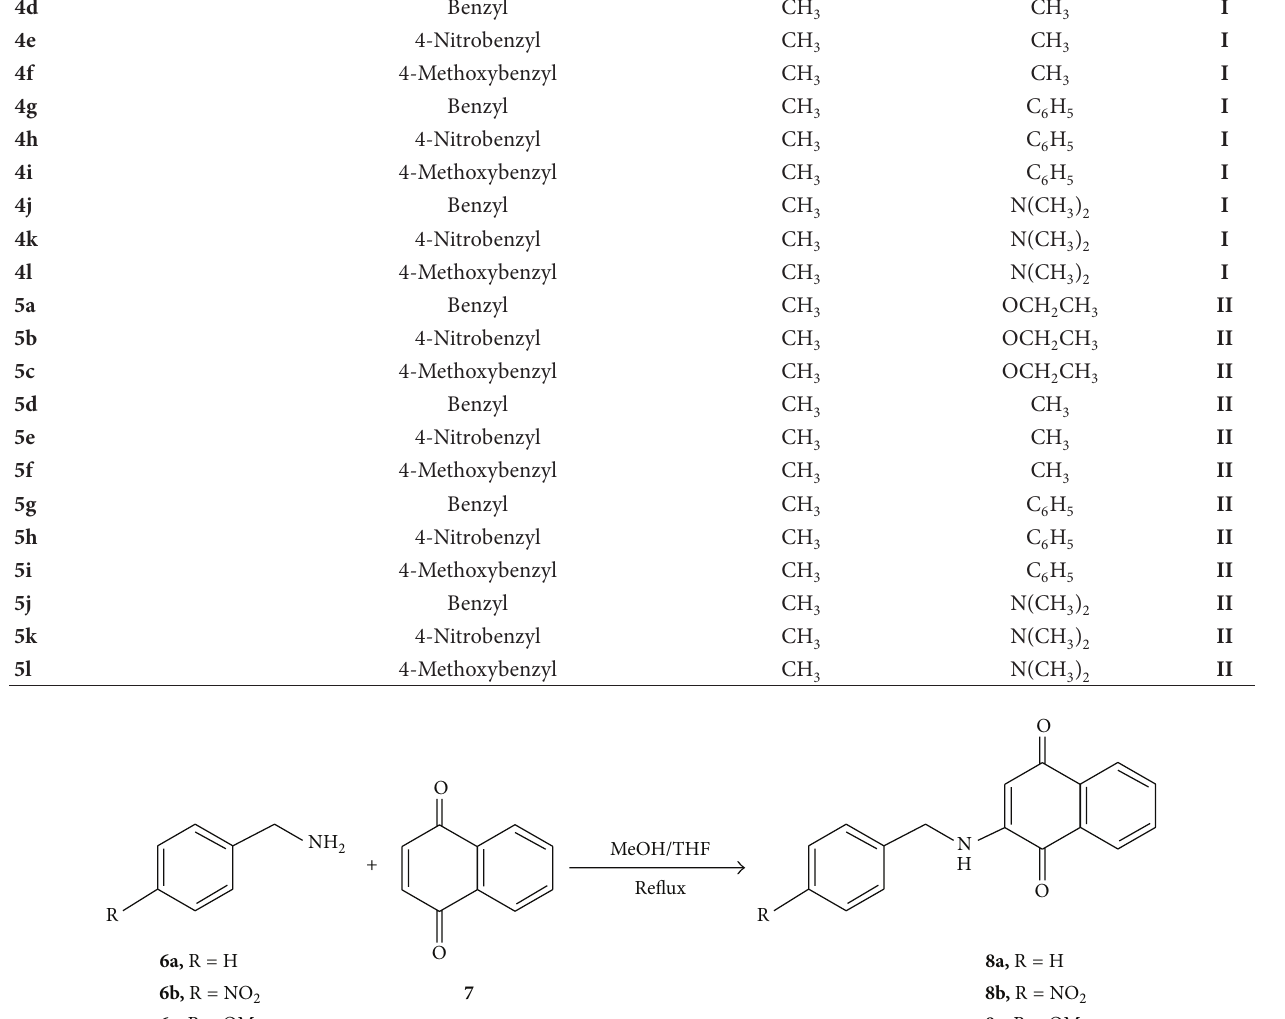
Scheme 1: Synthesis of